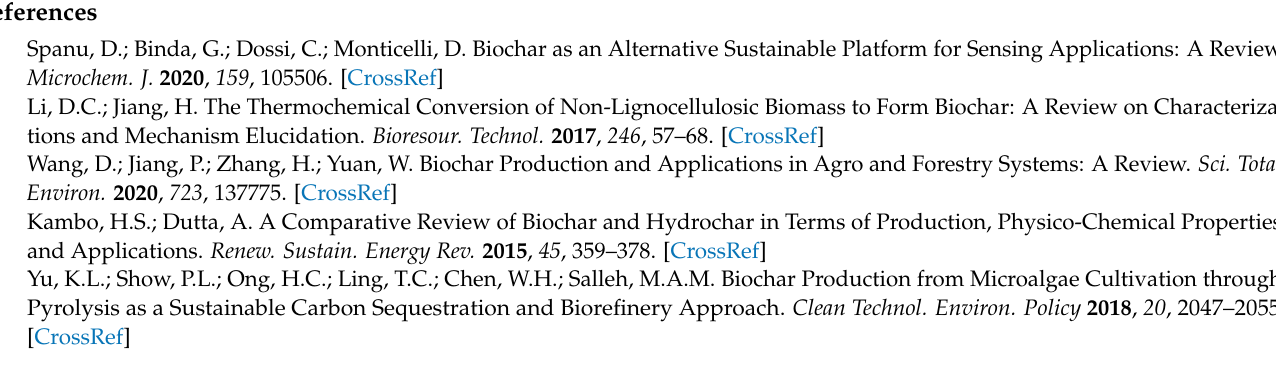
Table S4: Surface fitting of data obtained for Pb adsorption on